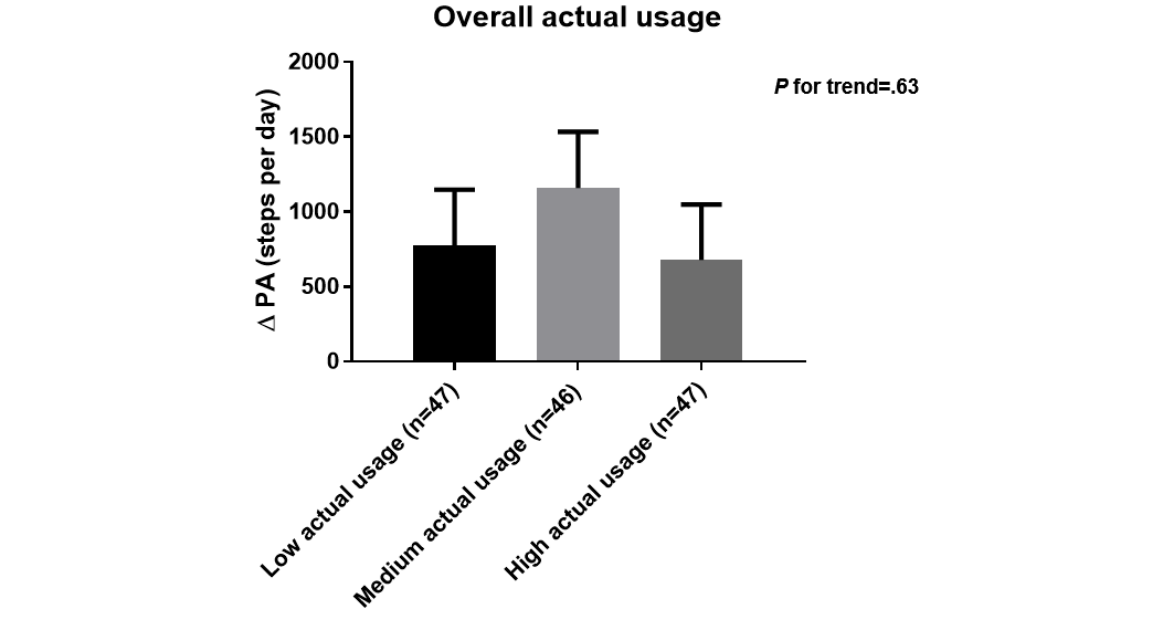
P valueHigh actual usage, >75% of